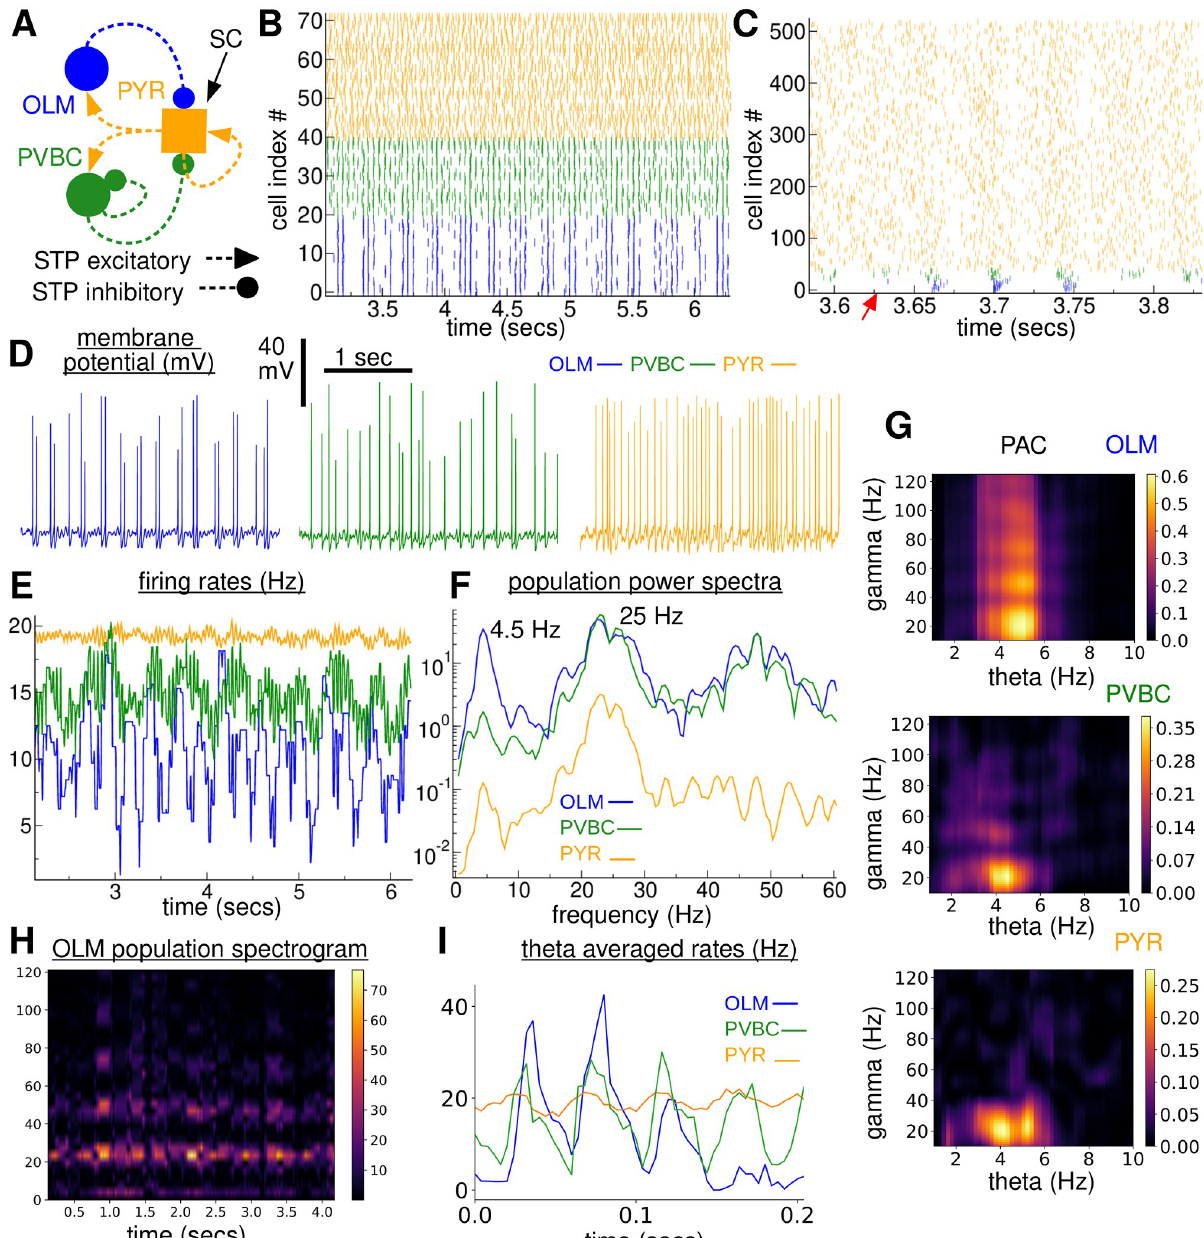
Fig 2. TSGPAC in a 480 PYR, 20 OLM, 20 PVBC cell network simulation of the ‘full model’, (FM). (A) Schematic of the circuit . (B) Raster plot showing all the OLM and PVBC but only 32 of the PYR cells . (C) Smaller time segment raster plot showing all 480 PYR. Red arrow indicates onset of a theta burst . (b,c) OLM (blue), PVBC (green), PYR (orange) . D Example simultaneously recorded membrane potential traces. (left) OLM, (middle) PVBC, (right) PYR . (E) Population firing rate time series . (F) Population activity power spectra for the three cell populations, log y-axis, (blue (OLM), green (PVBC), orange (PYR)) . (G) PAC comodulograms for (top) OLM, (middle) PVBC and (bottom) PYR cell population activity . (H) Spectrogram for the OLM population activity . (I) Theta cycle averaged population firing rates for the three cell populations